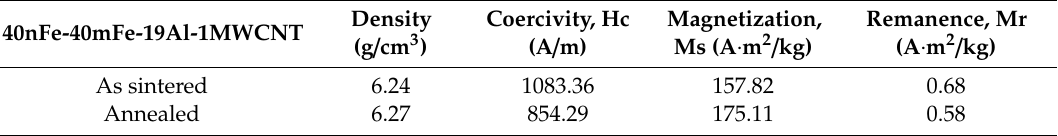
Figure 16. ( a ) Effect of the annealing heat treatment on the hysteresis loops of 40nFe-40mFe-19Al-1MWCNT; ( b ) magnified region in ( a ); ( c ) full XRD scan of the composites after and before annealing; ( d , e ) magnification of the XRD pattern in the angular range of 40–50° for the as-sintered and annealed, respectively; ( f ) crystallite size for the main peaks of the Fe(110)/Al(200), Fe-Al compounds and iron carbide phase present between 40 and 50°. Table 5. Effect of the annealing heat treatment on the magnetic properties of